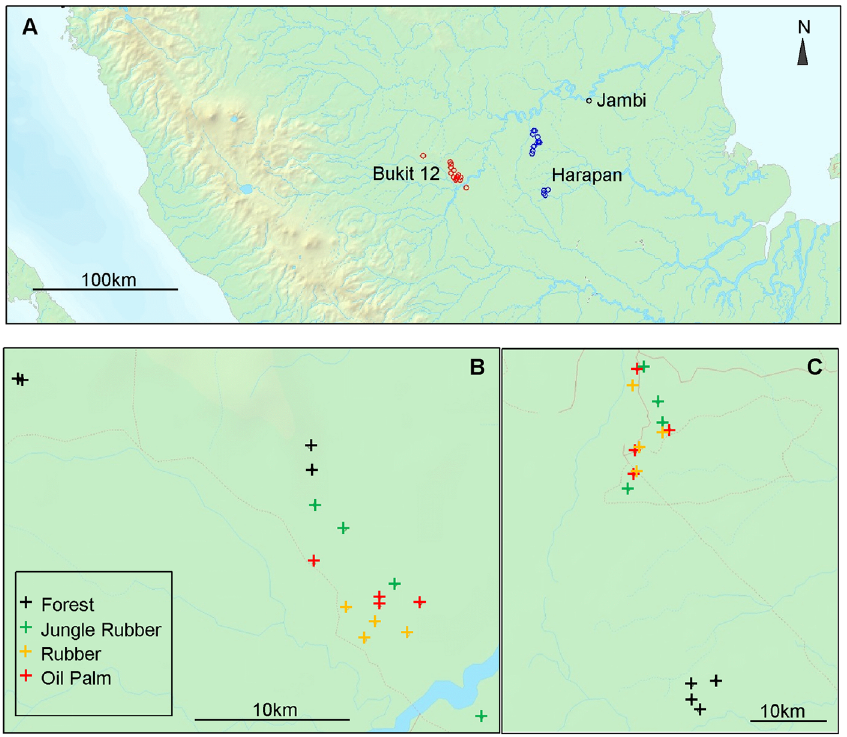
Fig 1. Maps of the province Jambi (A) with the landscapes Bukit 12 (B) and Harapan (C) on Sumatra (Indonesia). The locations of the research plots are